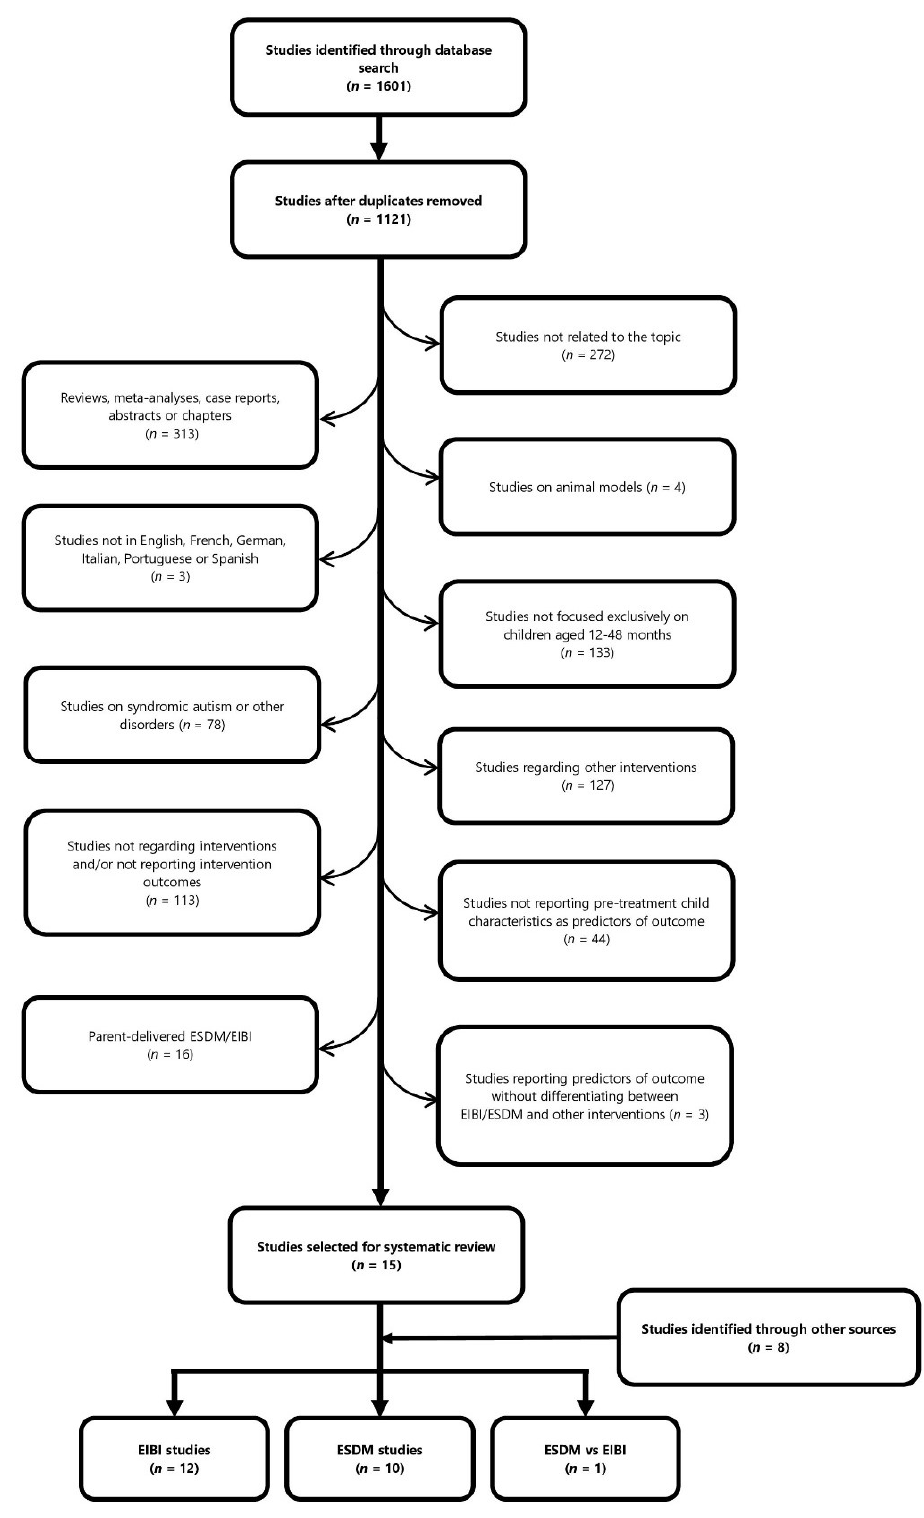
Figure 1. Study flow chart. EIBI: Early Intensive Behavioral Intervention; ESDM: Early Start Denver